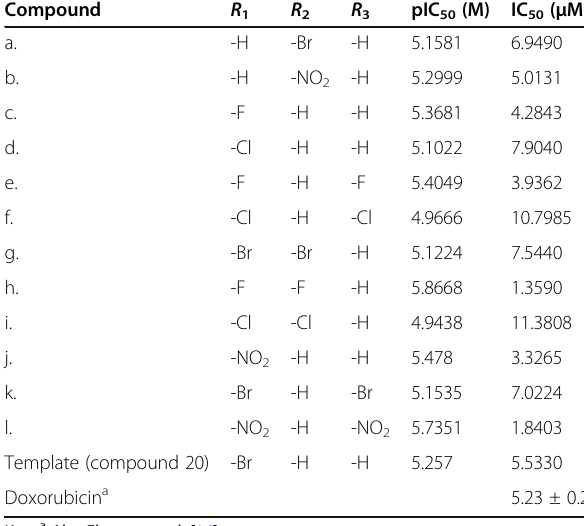
Table 6 Cytotoxic activity of designed compounds